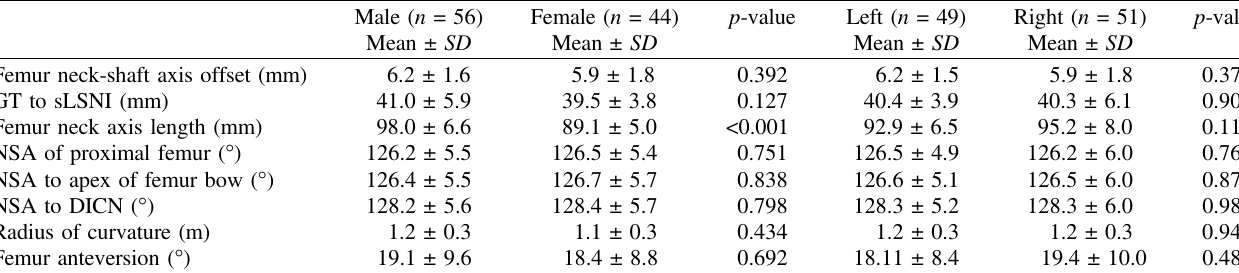
Table 3. Difference between measurements for male/female and left/right subgroups.